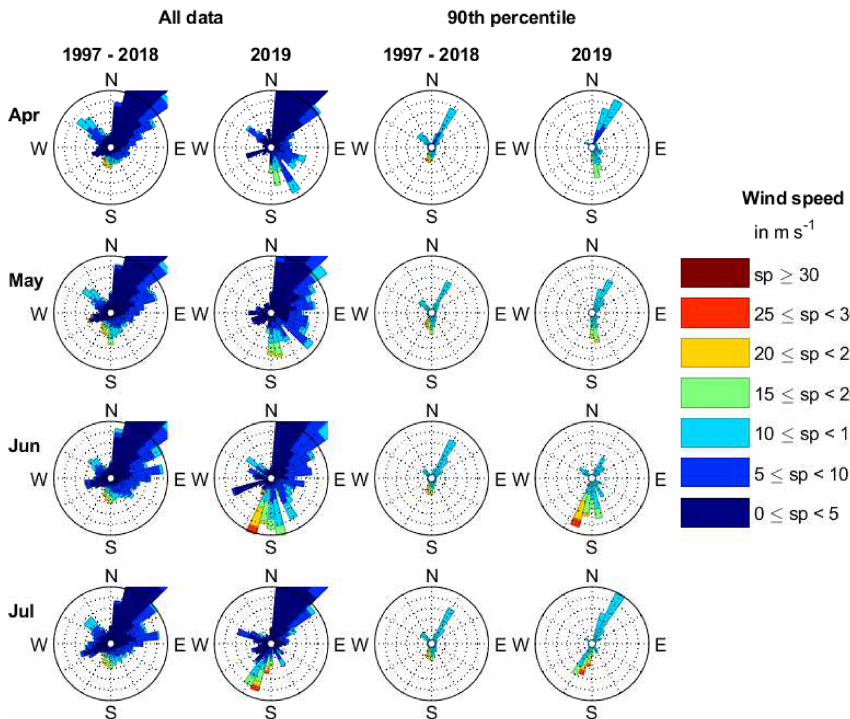
Figure 2. Wind roses constructed from Scott Base weather station data for the months of April–July. The first and second columns show the full data set for 1997–2018 and 2019, respectively, and the third and fourth columns show wind speeds equal to or greater than the monthly 90th percentile for 1997–2018 and 2019, respectively. The maximum frequency shown is 3%, with each circle representing an increment of 0.6%, and the wind direction is defined as the bearing from which the wind originated. The bin size of each spoke is 10 ◦ . Note that in the first two columns the prevailing northeasterly winds extend to a maximum of ∼ 30% (not shown) for all